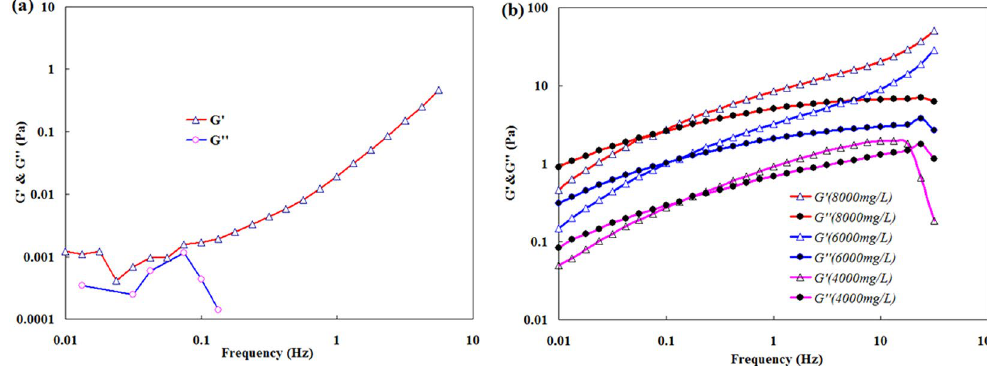
Figure 8. Viscoelastic curves of BD-HMHEC solutions of different concentrations. ( a ) BD-HMHEC concentration: 3000 mg/L. ( b ) BD-HMHEC concentrations: 4000 mg/L, 6000 mg/L, and 8000